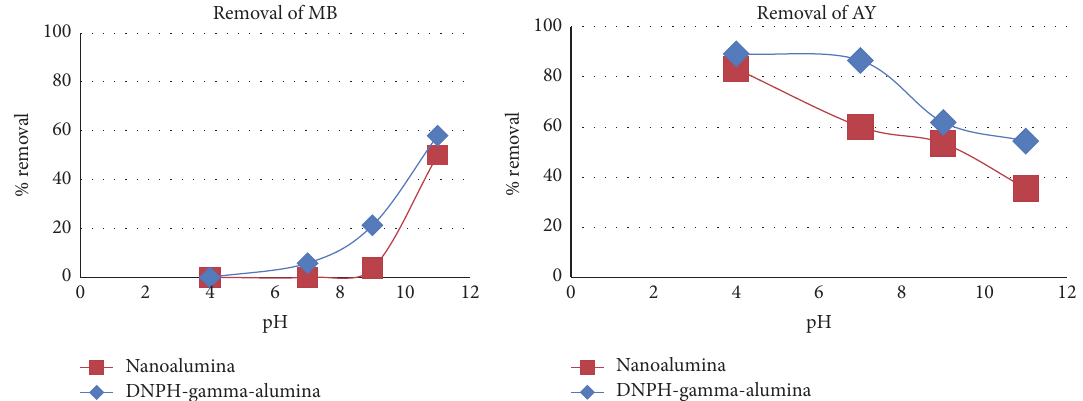
Figure 8: Effect of pH on the removal of the dyes, 50 mg/L of dye concentration, 90 min, 0.1g adsorbent amounts, and 298 K.